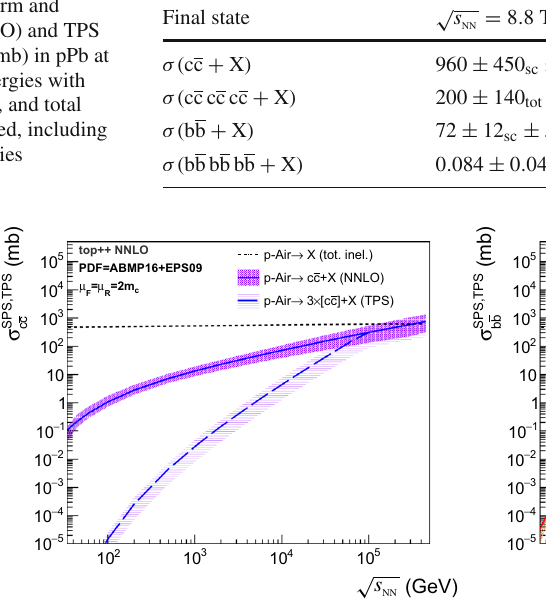
Fig. 2 Charm (left) and bottom (right) cross sections in p–Air colli- sions as a function of nucleon-nucleon c.m. energy, in single-parton (solid line) and triple-parton (dashed line) parton scatterings, compared